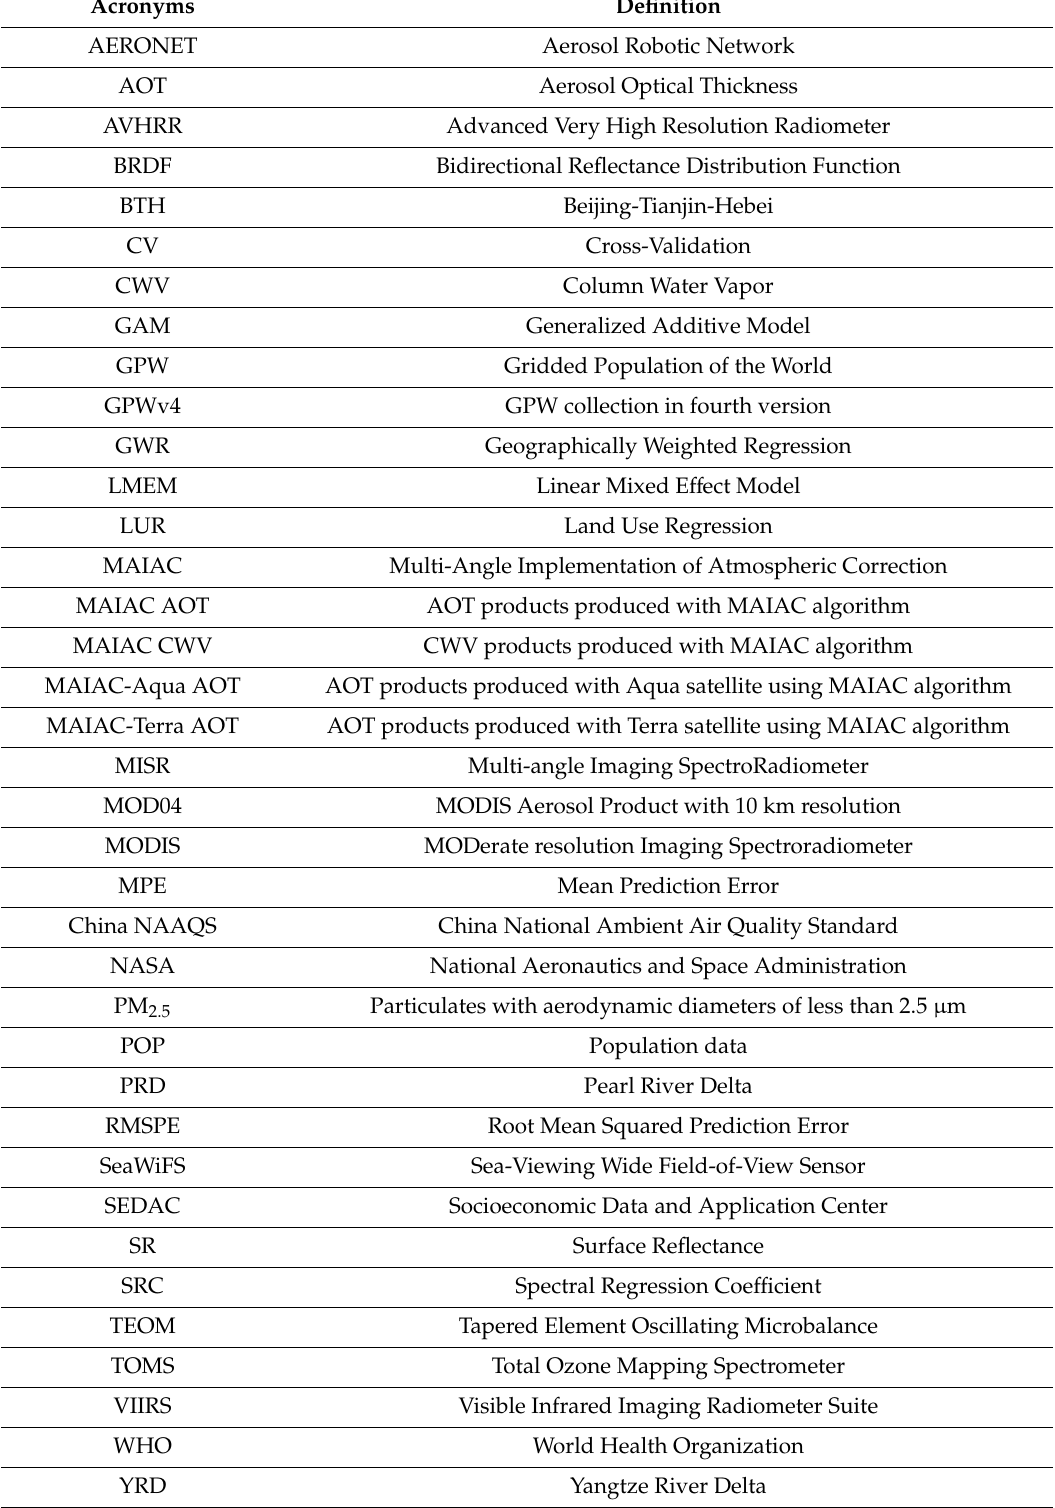
Table A1. The acronyms and definitions used in this article area displayed below